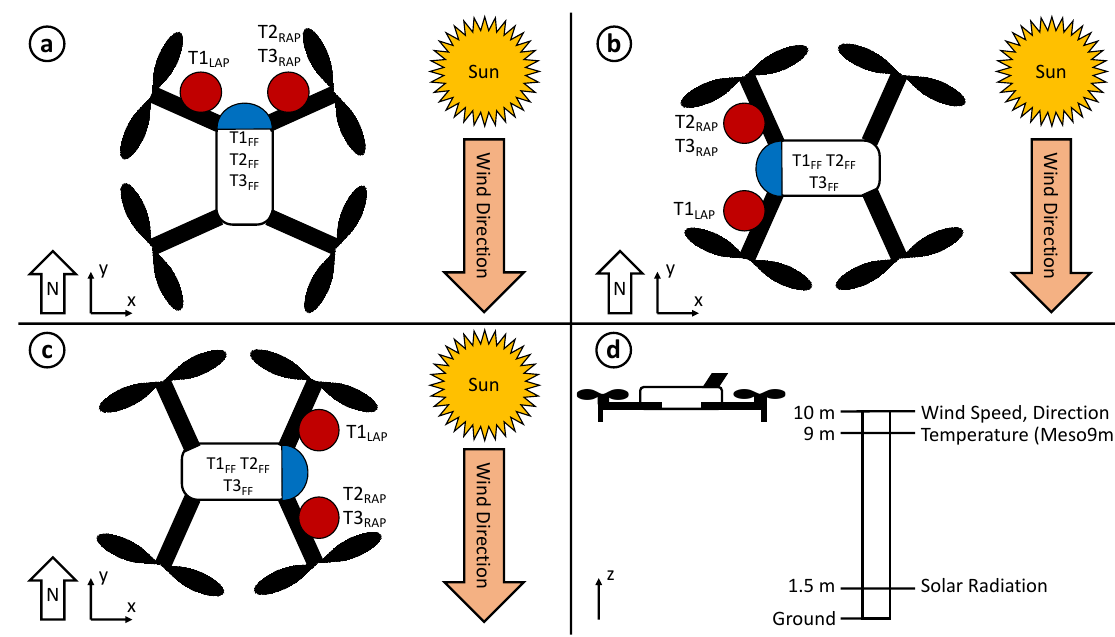
Figure 3. Schematic detailing the orientations of the CopterSonde relative to the sun and oncoming wind for experiments: ( a ) 1, 3, and 5; ( b ) 2 and 4; and ( c ) 6 and 7; ( d ) the CopterSonde hovered at 10 m for each experiment directly adjacent to the Washington Mesonet tower, which had sensors located at 1.5, 9, and 10 m (figure dimensions not to scale).